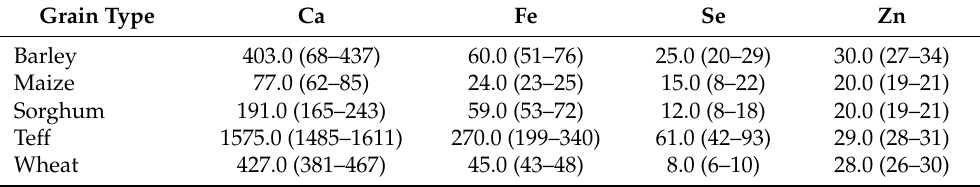
Table 1. District-level mineral micronutrient concentrations (mg kg − 1 ) in cereal grains in Ethiopia.